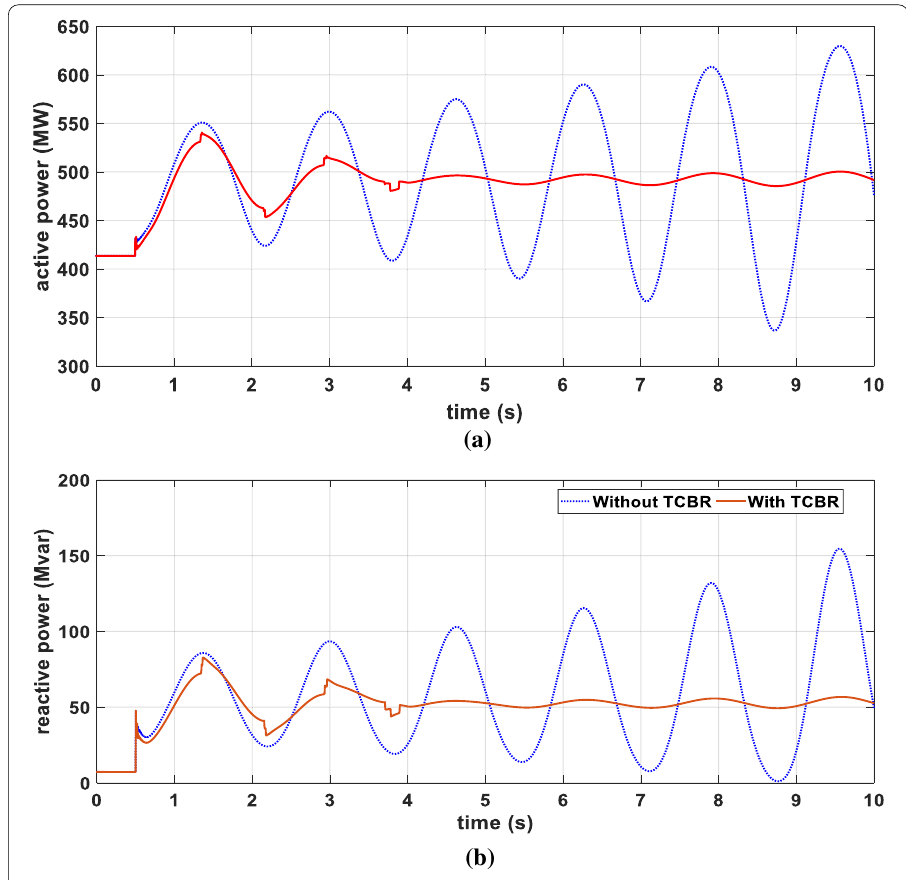
Fig. 8 Power flow responses to the heavy load increase with and without the TCBRs interventions, a inter‑area active power flow, b inter‑area reactive power